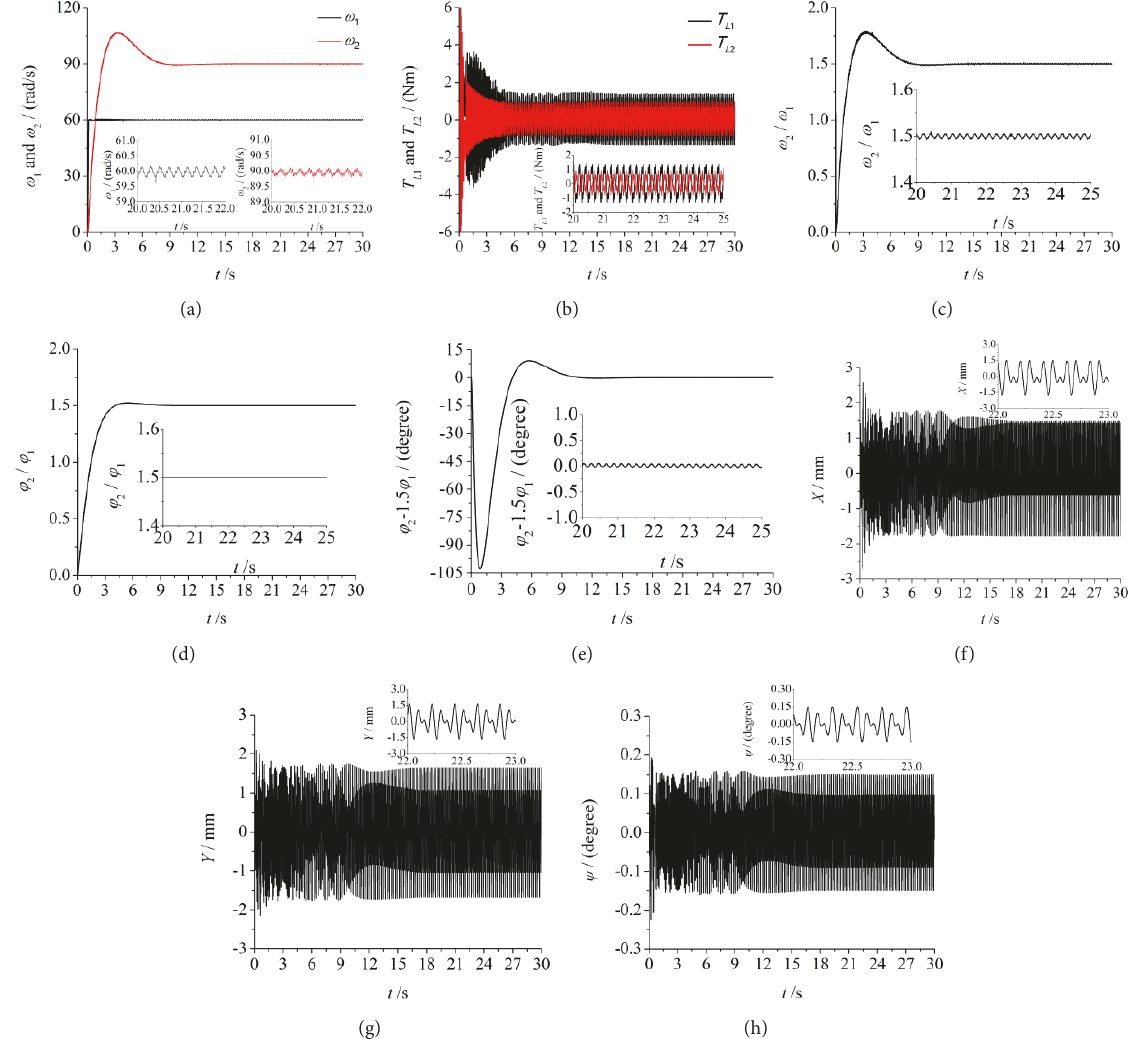
Figure 8: Multifrequency controlled synchronization for the situation 𝑛 = 1.5 , where 𝛼 0 = 0 . 𝛼 0 is the initial phase difference. (a) Speed of the motors; (b) load torque; (c) speed ratio; (d) phase ratio; (e) phase difference; (f) response of 𝑥 direction; (g) response of 𝑦 direction; (h) response of 𝜓